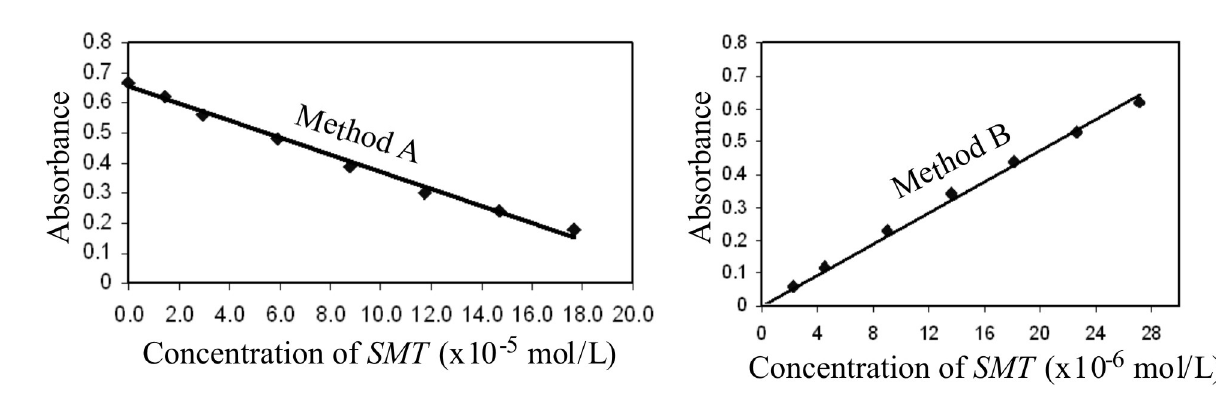
FIGURE 2 - Tentative reaction scheme.